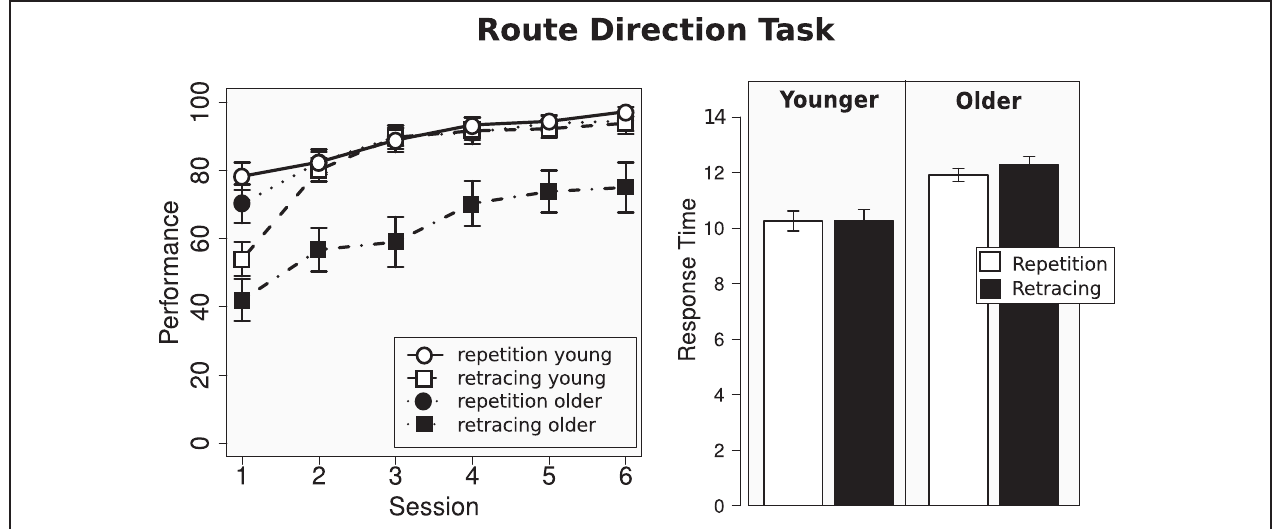
FIGURE 2 | Left: performance for the Route Direction Task ; right: response time for test trials featuring a turn at the first intersection encountered.